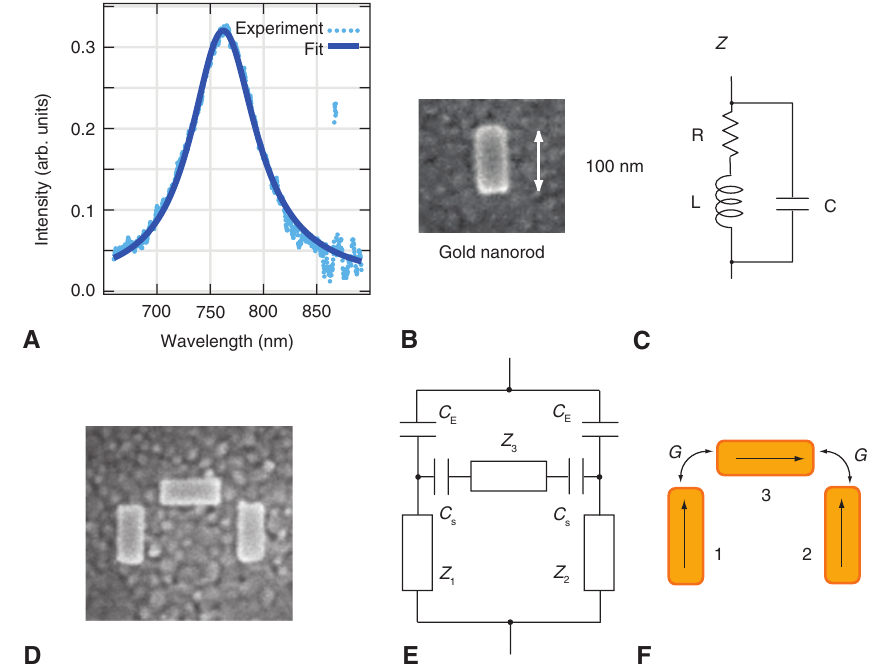
Figure 6: Plasmonics as electronics. (A) An example of the scattering spectrum from a single gold nanorod l = 100 nm, w = 40 nm, t = 30 nm; (B) SEM image of the resist used to define a gold nanorod during lithography; (C) the equivalent circuit impedance of the rod – the spectrum is fit to I = A + B | Z | 2 where Z = ( R + j ω L )/(1 − ω 2 LC + j ω RC ) is the circuit impedance. The fit gives the lumped component values RC = 3.99 × 10 −17 s and LC = 1.64 × 10 −31 s 2 and the resonant frequency is π = = 1/2 393 THz; f LC (D) a three-nanorod structure that mimics a Wheatstone bridge circuit [150, 151]; (E) the equivalent electrical circuit; (F) an alternative analysis using plasmon coupling theory [152] that gives = [ G p · (E − E )]/[( δω + i Γ /2) 2 − 2 G 2 ] directly in terms of parameters associated with the optics plasmon excitation amplitude on nanorod 3 ã 3 1 2 of nanoparticles – the detuning δω from the single rod resonance of FWHM Γ , dipole moment p and interparticle coupling G . The LSP amplitude depends on the difference in the electric fields E − E of the light incident on the two parallel rods, 1 and 1 2